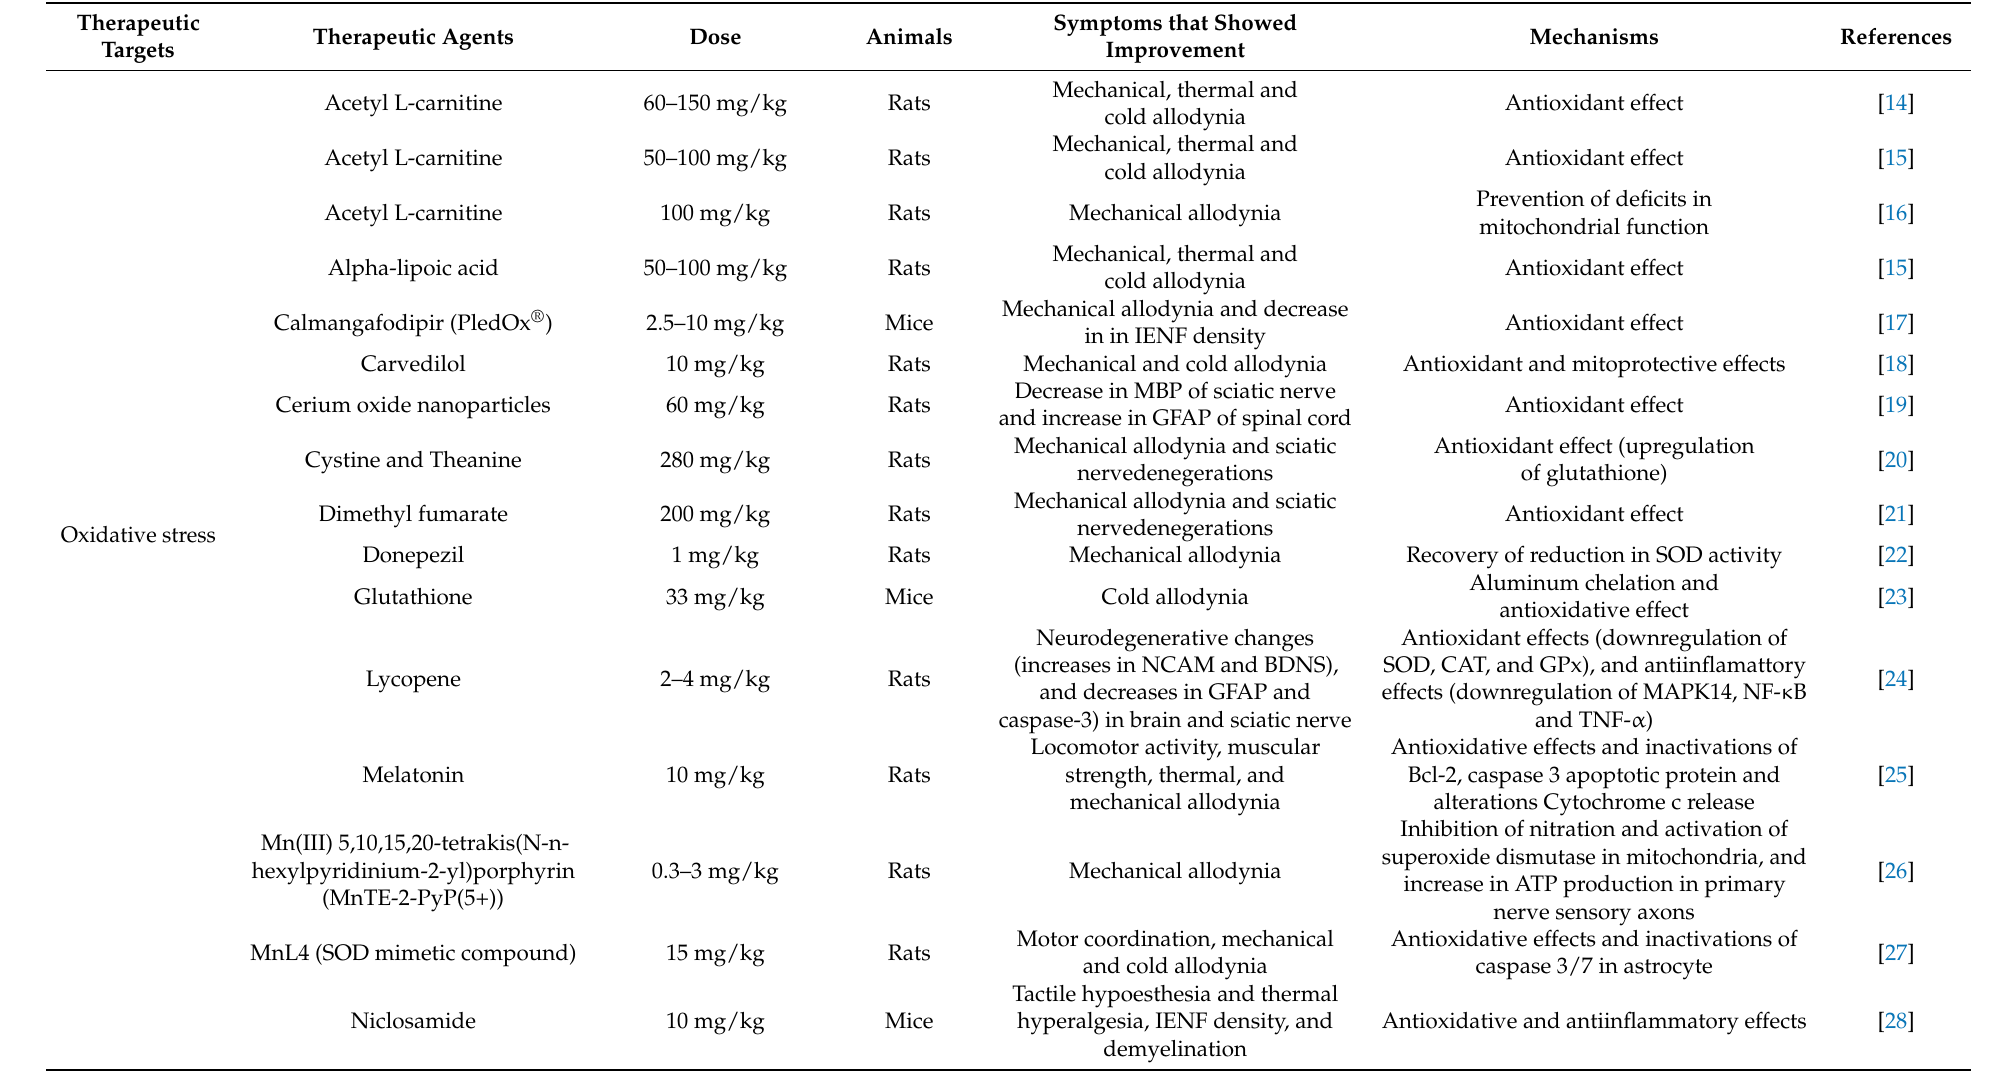
Table 1. The therapeutic agents for oxaliplati-induced peripheral neuropathy in preclinical